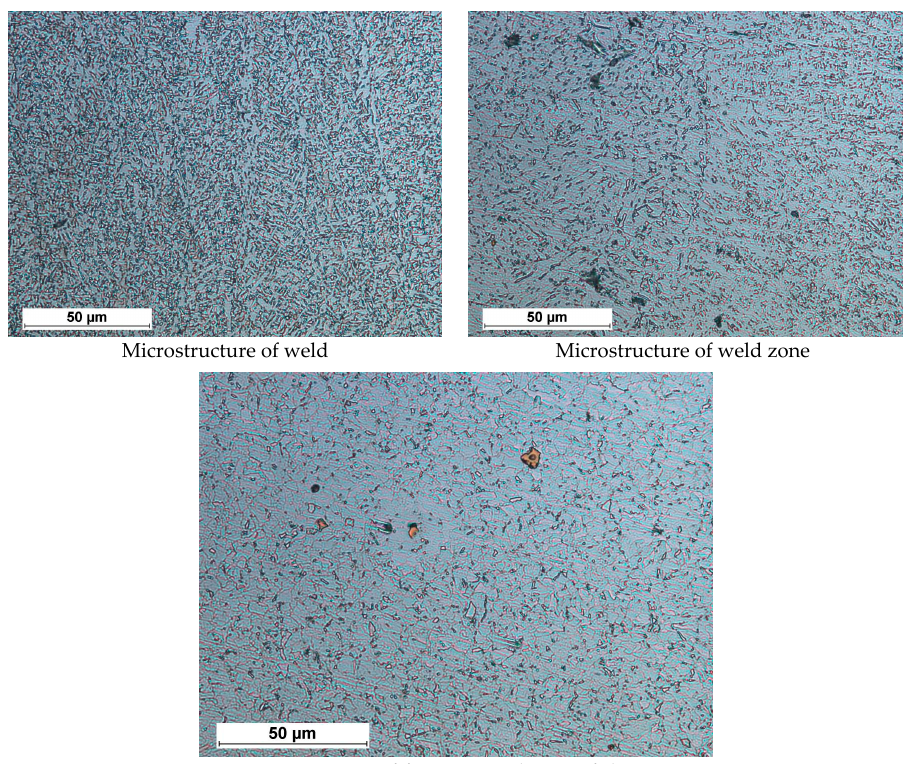
Figure 8. Effect of welding method and input heat on the hardness on the cross section of the S700MC welded joints.